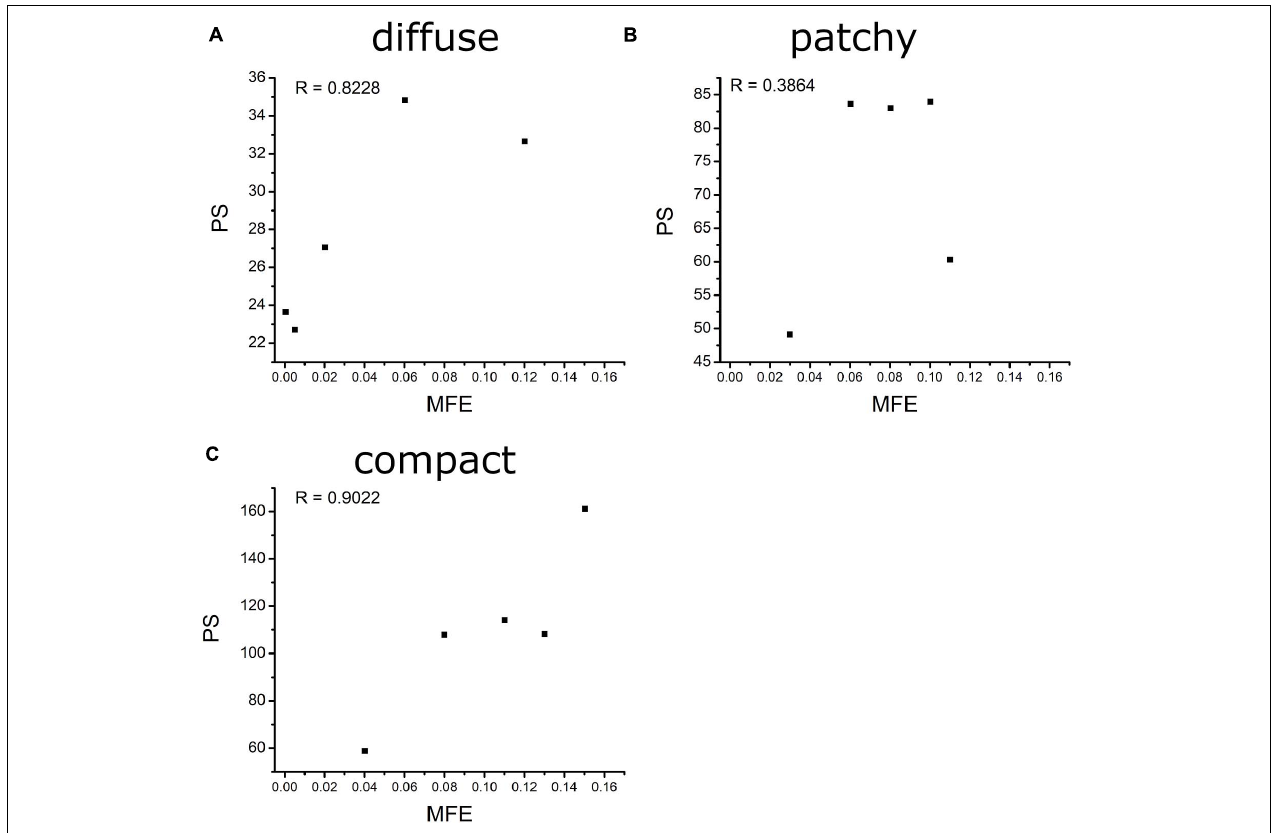
FIGURE 7 | Correlation between MFE and MPS of diffuse (A) , patchy (B) , and compact (C) fibrosis